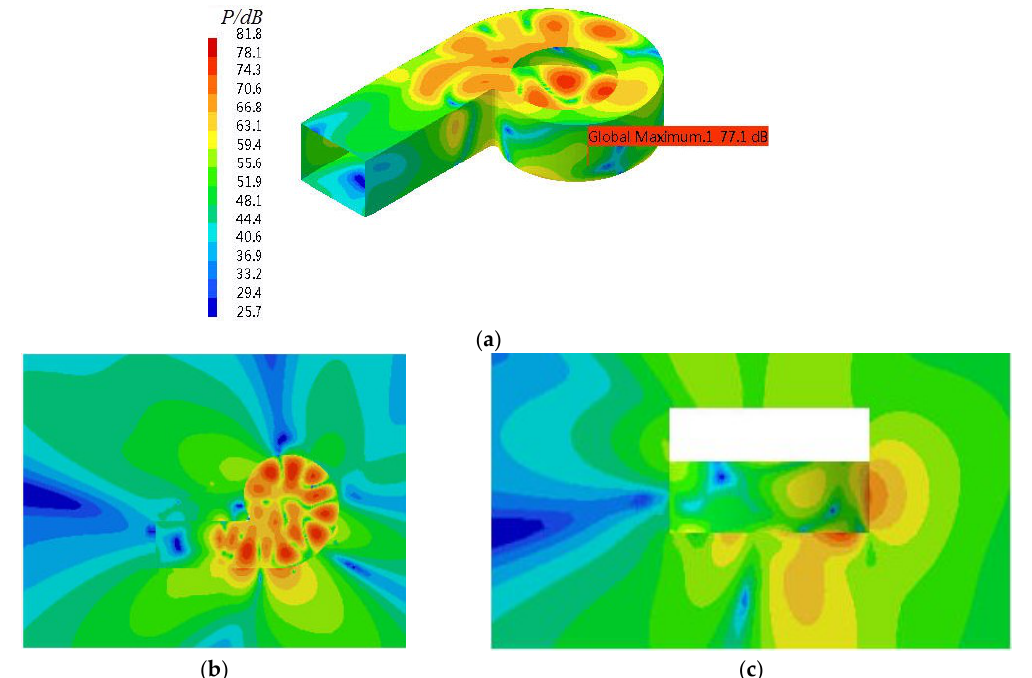
Figure 29. Distribution of vibrational sound radiation after the total mass invariable optimization at the fundamental frequency. ( a ) The whole volute body; ( b ) XY section; ( c ) ZY section.